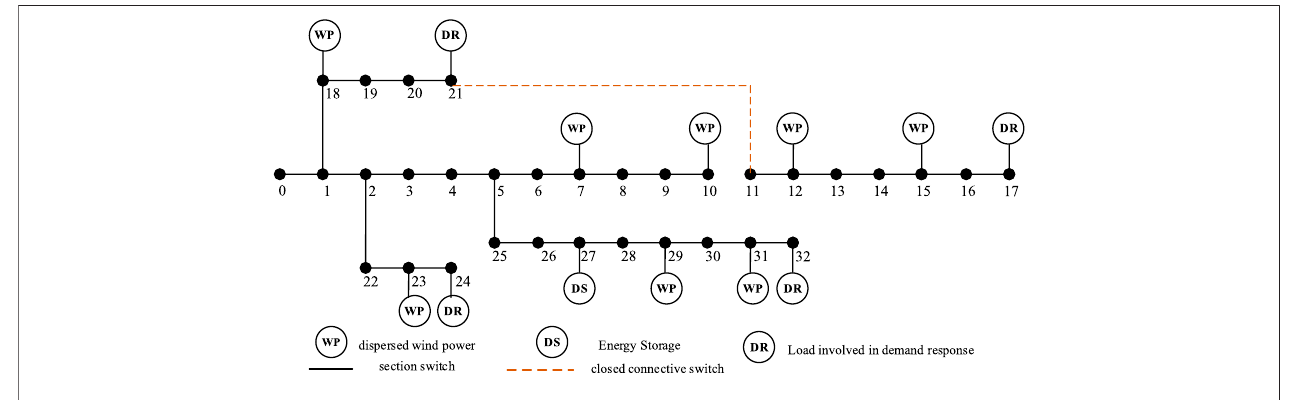
FIGURE 4 | Network topology of strategy